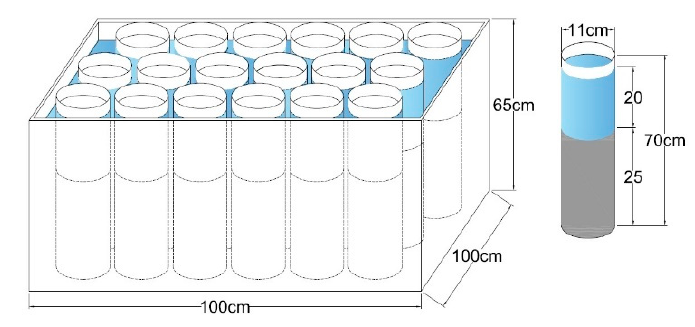
Figure 2. The design of the experimental wetland habitat simulation device.